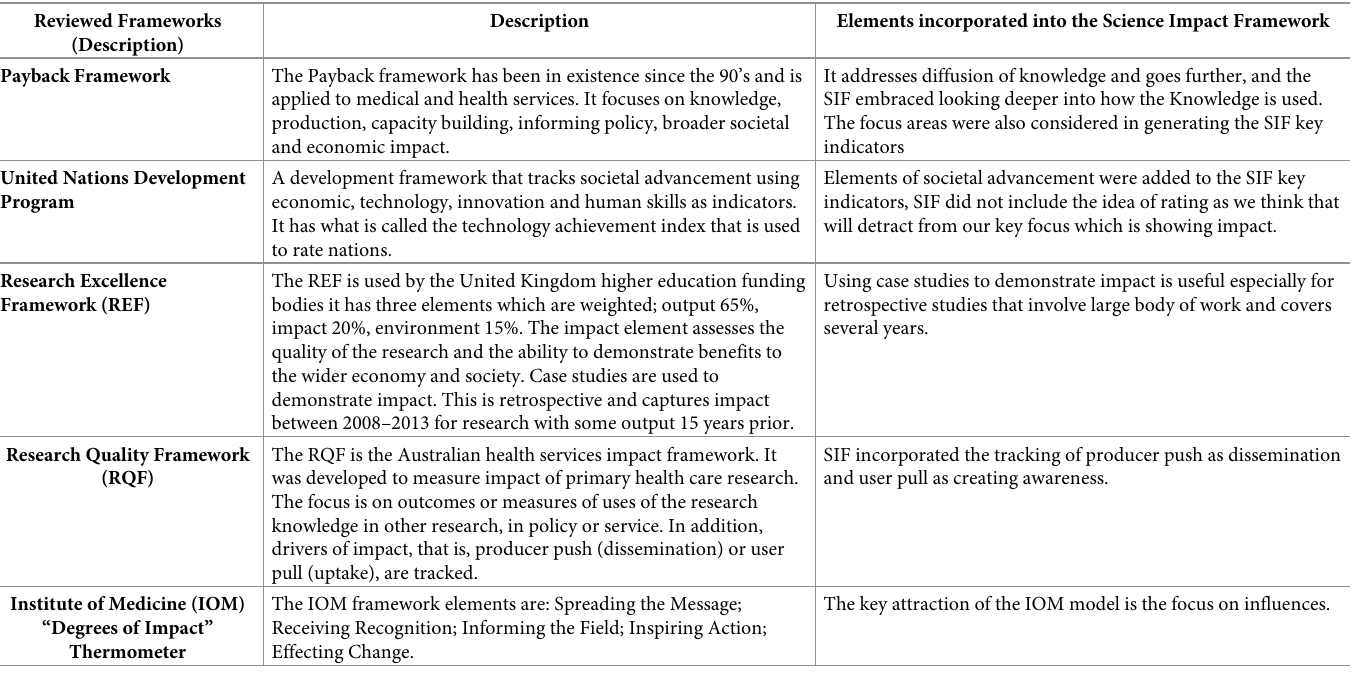
Table 1. Description of impact frameworks